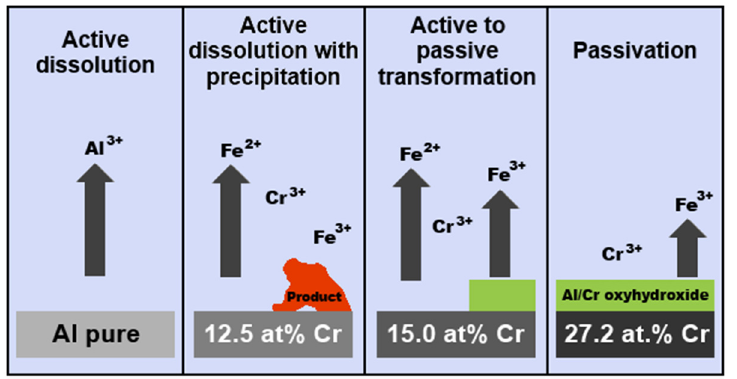
Figure 15. Schematic of passivation/dissolution processes on pure Al and Al–Cr–Fe alloys in aqueous HCl + NaCl mixture with initial pH 2, re-drawn from reference [92].